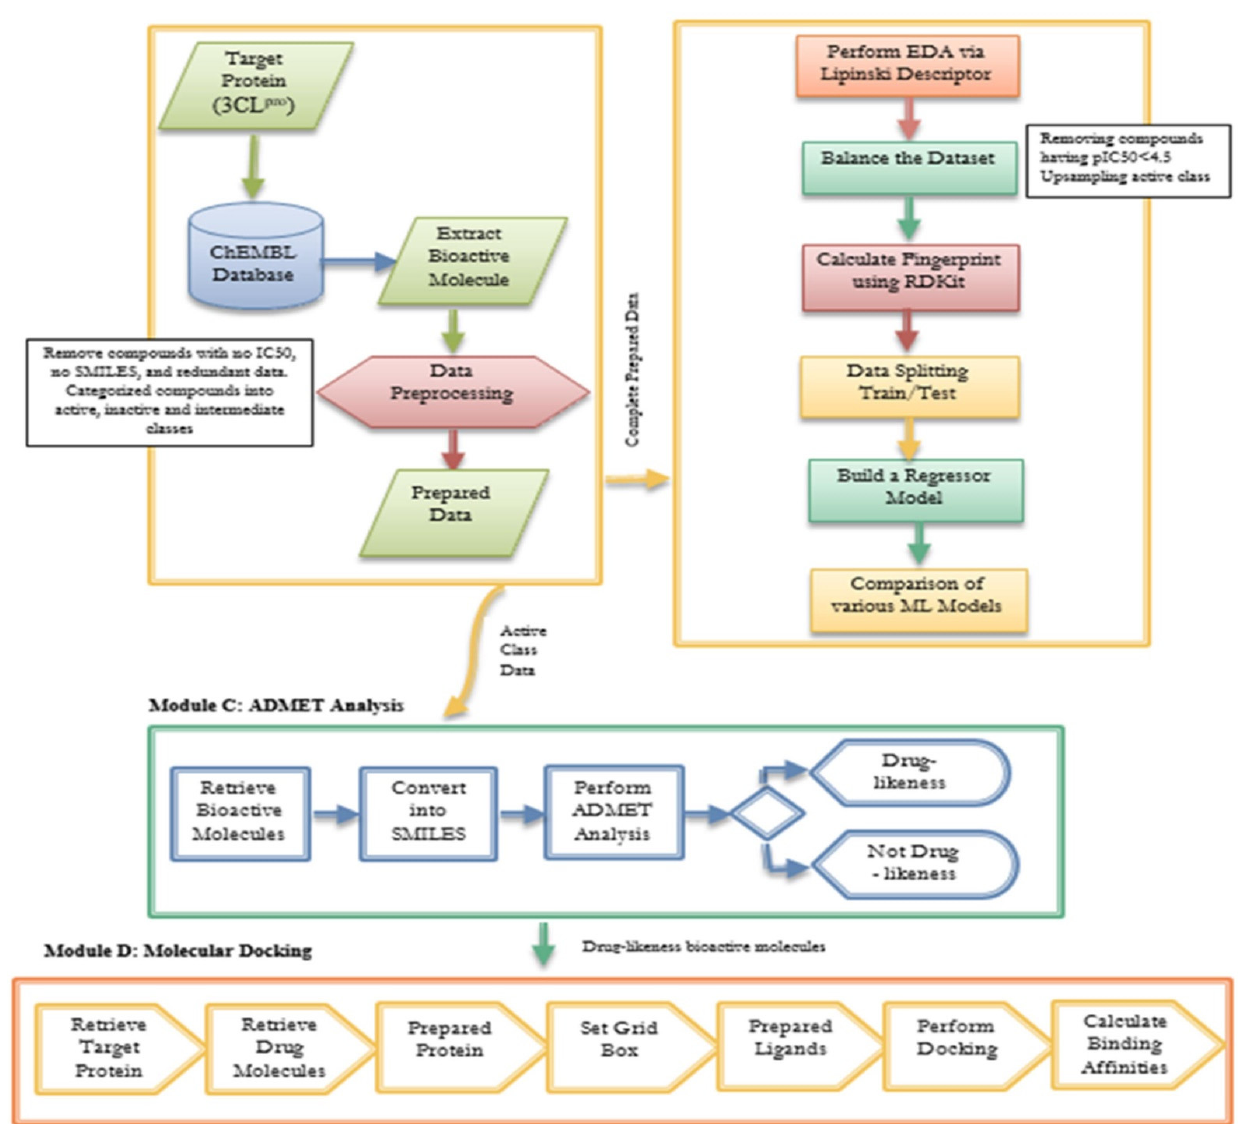
Figure 6. Four main modules (A to D) in the proposed hybrid